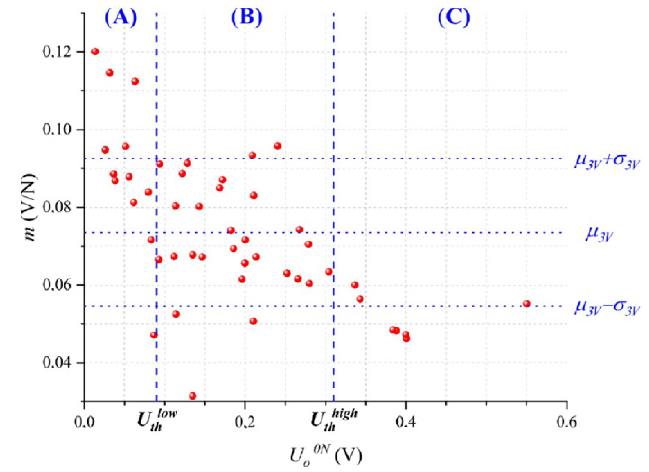
Figure 5. Sensitivity ( m ) as a function of the output voltage at null force ( U o0N ) for each specimen. The sensitivity data were fit to a Gaussian probability distribution resulting in the mean, μ 3V = 0.0735 V/N, and standard deviation, σ 3V = 0.019 V/N. Low threshold voltage ( U thlow ) and high threshold voltage ( U thhigh ) were defined for classification purposes. Data were taken at U = 3 V for 48 sensors.